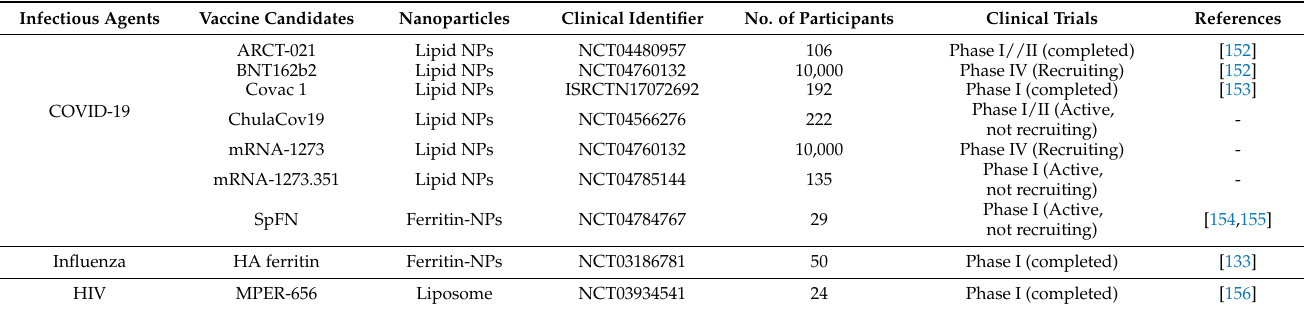
Table 1. Nanoparticle-based vaccines against infectious diseases in clinical